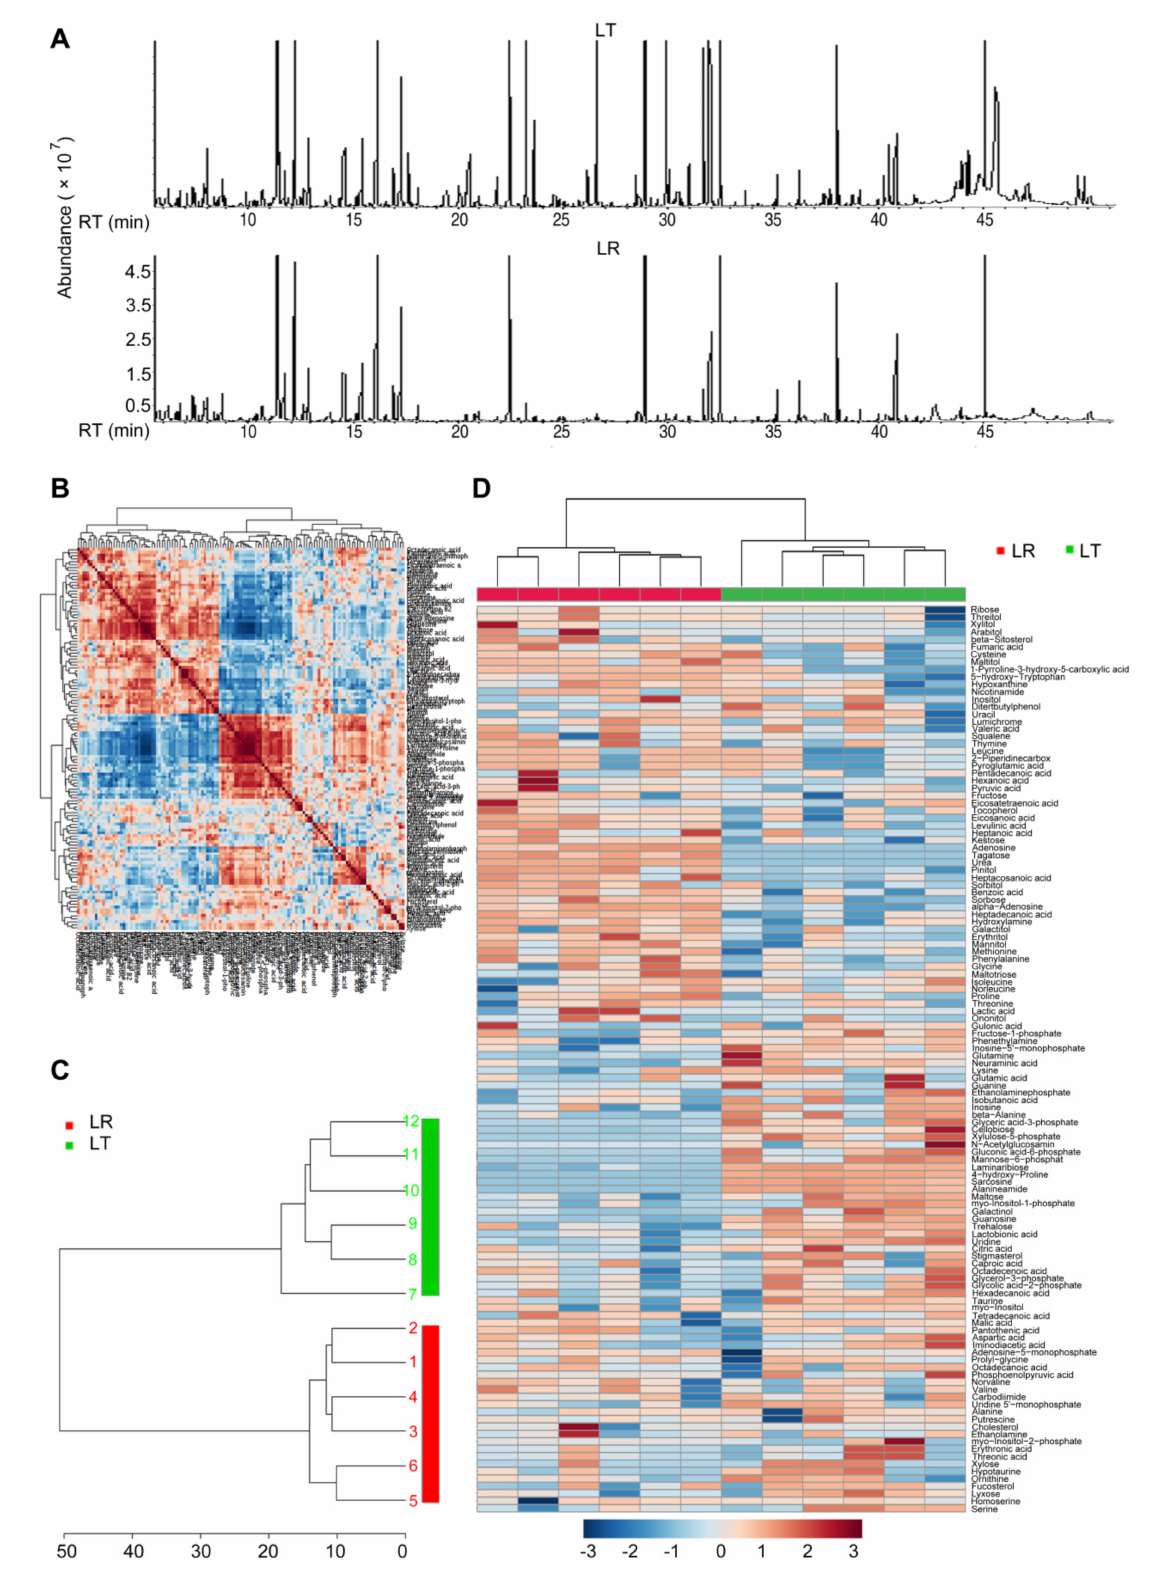
Figure 1. Experimental design outline and metabolomic profiling of 35 d embryos of Lantang (LT) and Landrace (LR) pigs. ( A ) Three representative total ion current chromatograms from Lantang